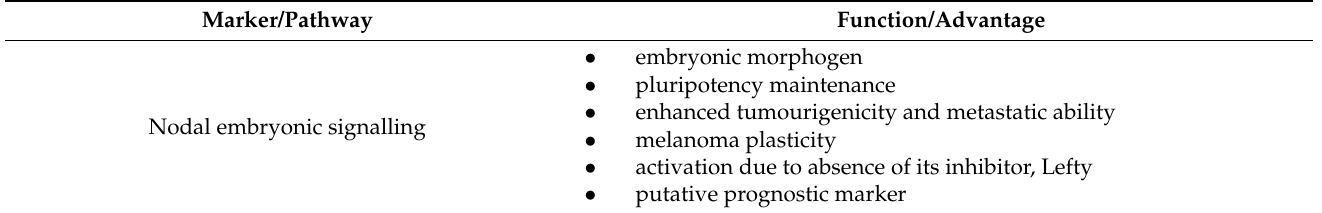
Table 5. Melanoma CSCs